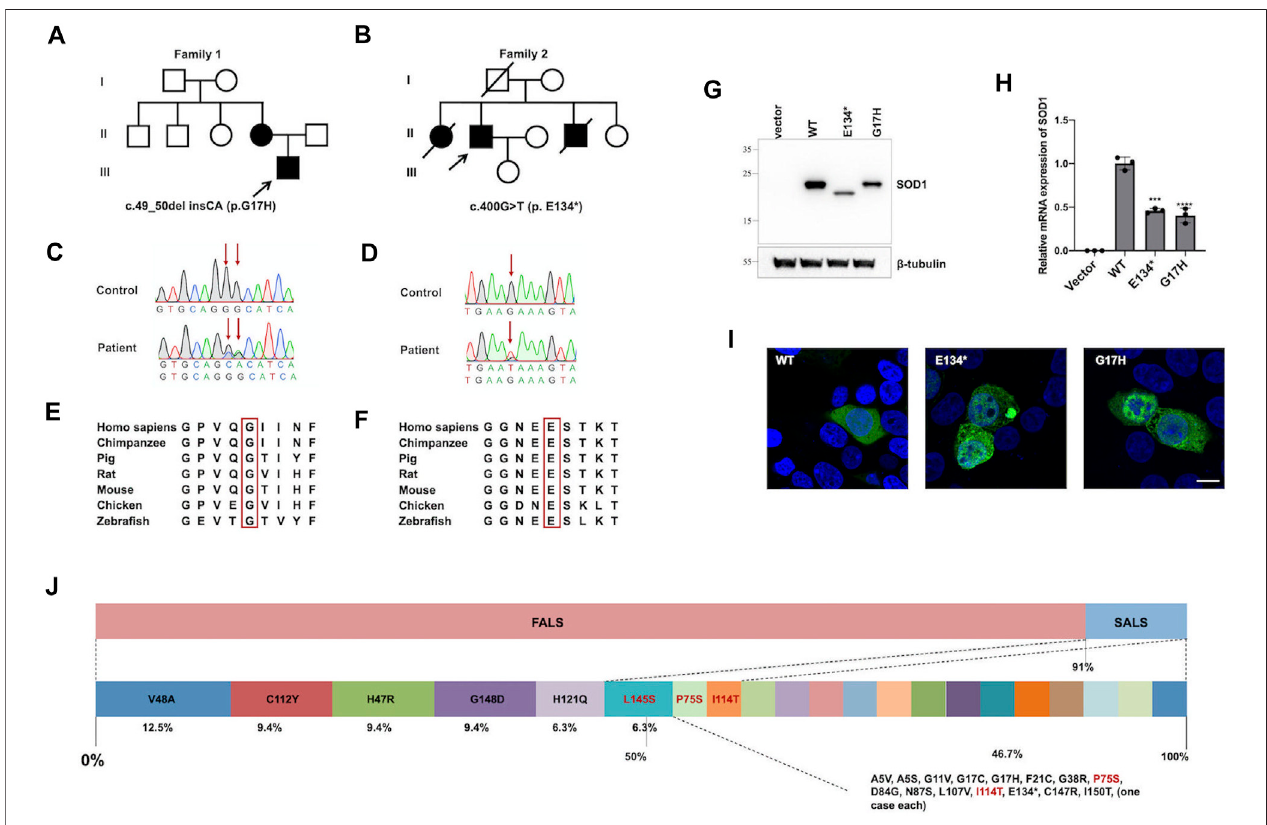
FIGURE 1 | SOD1 novel variants identi fi ed in patients, functional study, and SOD1 mutation distribution. (A,B) Pedigrees of two ALS families carried missense variants of the SOD1 gene; arrows indicate the proband of the family. (C,D) Sequence of c.49_50del insCA (p.G17H) and c.400G > T (p.E134*) variants in SOD1 are shown; arrows indicate variant sites. (E,F) The p.G17H and p.E134* variants were highly conserved from chimpanzee to zebra fi sh. (G) HEK293T cells were transiently transfectedwithplasmidsexpressingVector,p.WT,p.G17H,andp.E134*.The SOD1 proteinwasdetectedbyanti-Flagantibody. (H) Quantitativereal-timePCRof SOD1 mRNAlevelsinHEK293Tcellstransfectedwithemptyvector,WT,ormutant fl ag-tagged SOD1 vectors.GAPDHwasusedasaninternalcontrol.Thedatashown are representative of three independent experiments. Error bars indicate SDs, *** p < 0.001, **** p < 0.0001 (one-way ANOVA). (I) Immuno fl uorescence confocal of HEK293T cells expressing WT or mutant SOD1 . (J) Mutation spectrum in SOD1 gene of southeastern Chinese ALS patients in our ALS